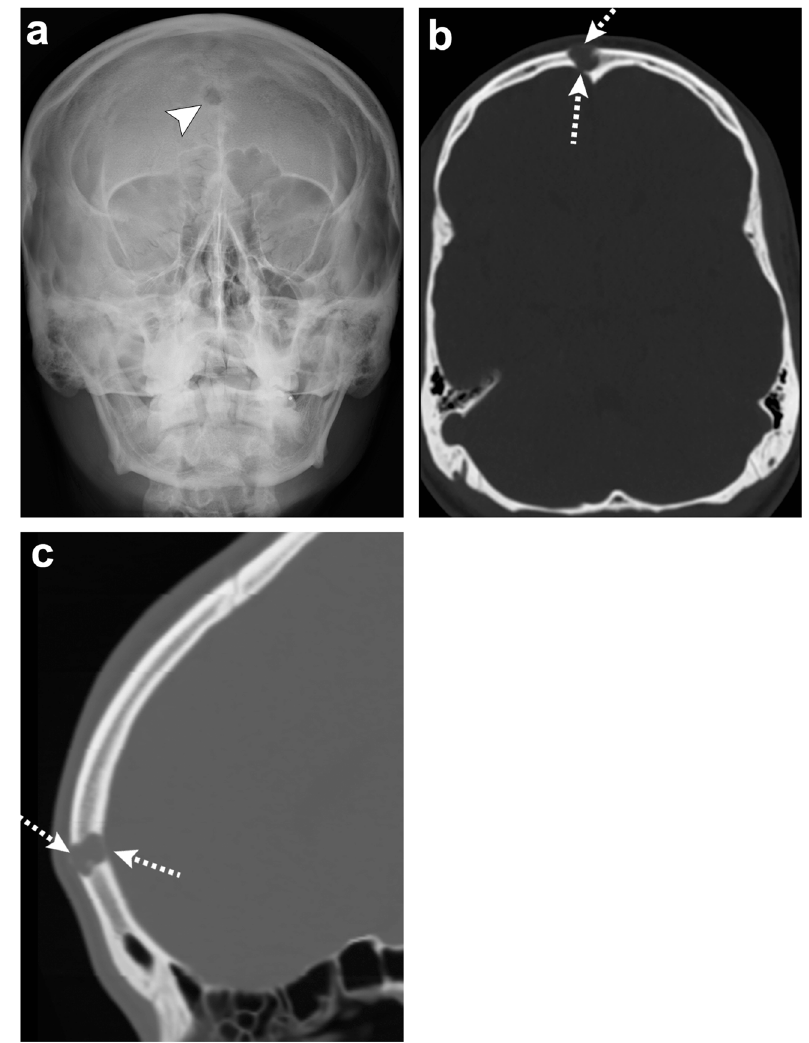
Fig. 12 Ossifying fibroma. Water view skull radiograph ( a ), axial ( b ) and sagittal ( c ) head CT images show a lytic lesion in the frontal bone ( arrowhead ) with barely perceptible anterior and posterior cortical margins ( dashed arrows